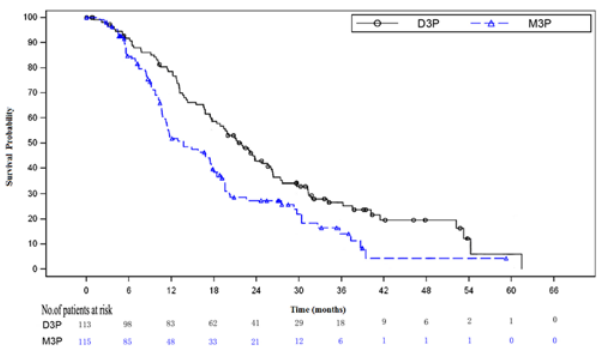
Figure 2. Kaplan-Meier curve for overall survival by different treatment arms in the intention to treat analysis. The Kaplan-Meier curve for D3P arm was above the curve for M3P arm, log-rank analysis proved this difference was statistically significant (P = 0.0011, HR = 0.63, 95% CI [0.46 – 0.86]). D3P = docetaxel plus prednisone arm. M3P = mitoxantrone plus prednisone arm.